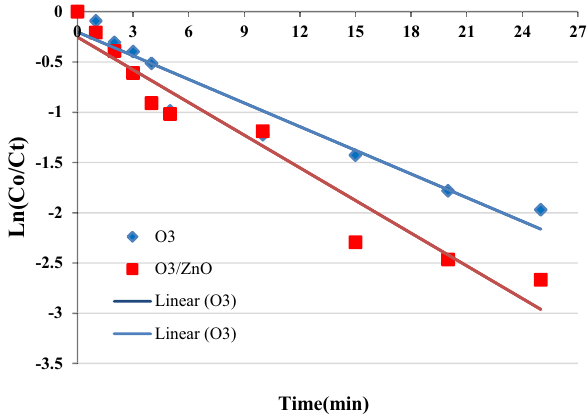
Fig. 12 Testing first-order kinetic for OTC